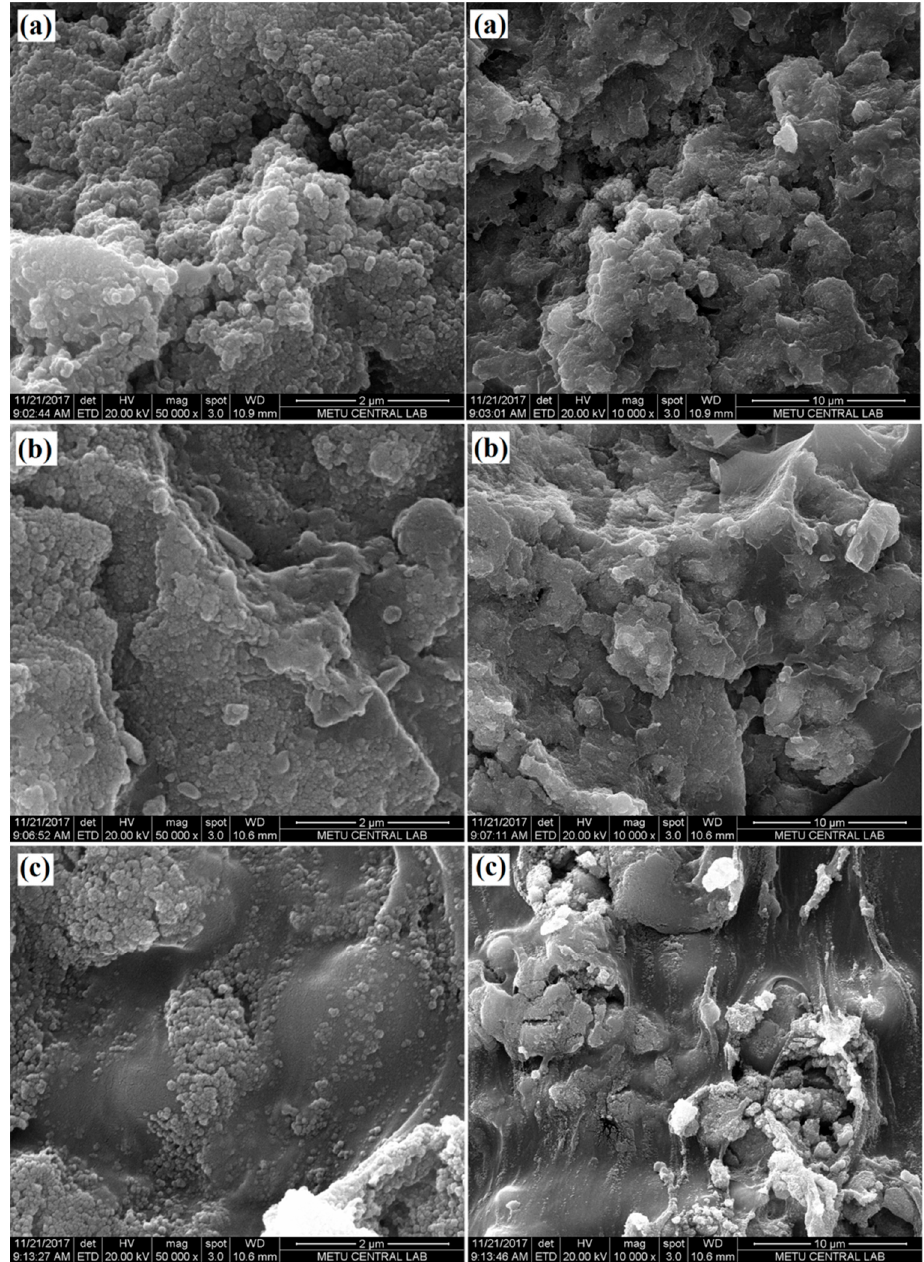
Figure 3. Scanning electron microscopy (SEM) images of ( a ) PVB/TiO 2 (5 wt.%) composite, ( b ) PVB/TiO 2 (10 wt.%) composite and ( c ) PVB/TiO 2 (15 wt.%) composite.